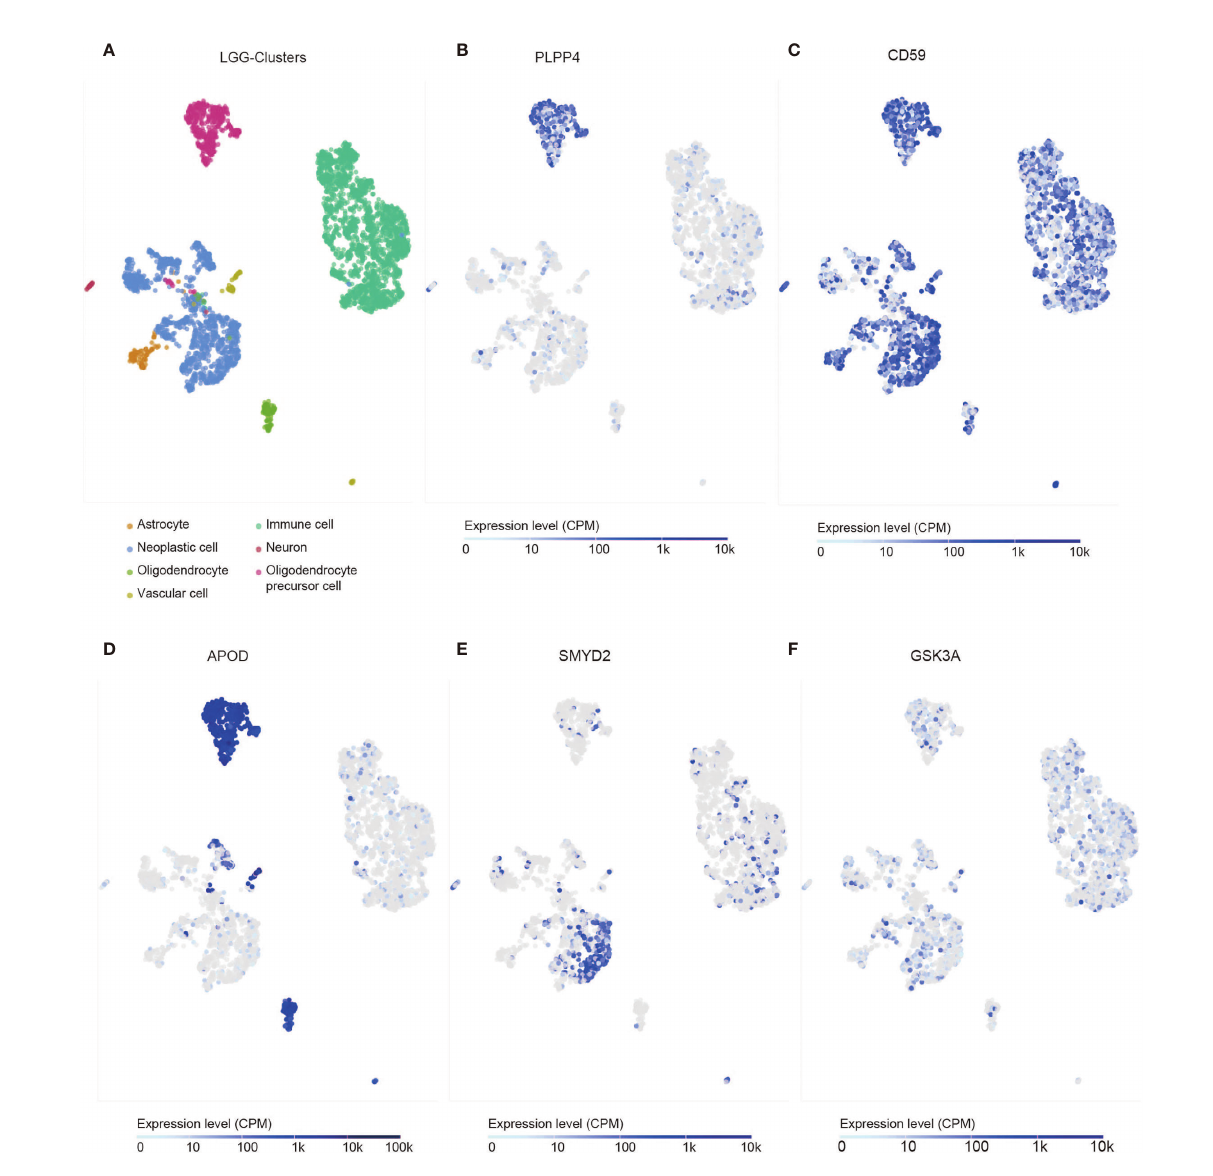
FIGURE 10 | Single-cell RNAseq analysis of PLPP4 and other genes at the migrating front of human glioma. (A) Major cell groups were identi fi ed for glioma. The cells were categorized into 7 clusters. (B – F) Co-expression of PLPP4 and other genes in